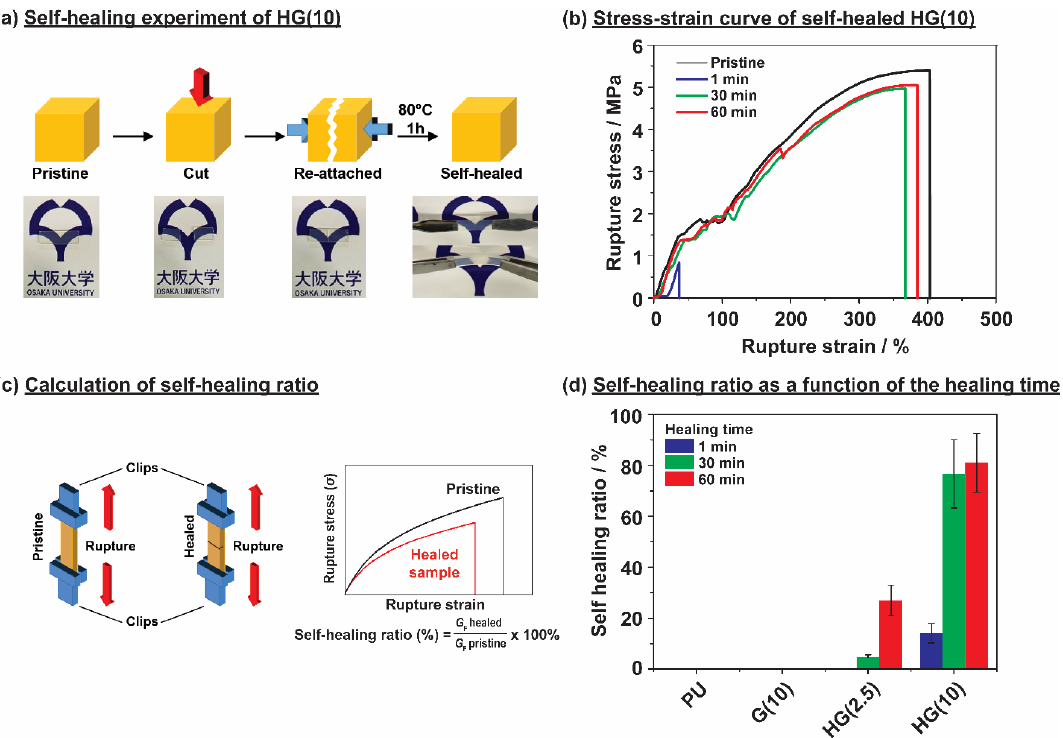
Figure 5. ( a ) Photographs of the self-healing experiment for HG(10). ( b ) Stress-strain curve of self-healed HG(10) at 80 ◦ C after 1 min, 30 min, and 60 min. ( c ) Calculation of the self-healing ratio. ( d ) Self-healing ratios of all the TPUs as a function of time. Calculated from the fracture energy. The prepared TPUs are host-guest TPU (HG( x )), linear TPU (PU), and guest TPU (G( x )). The proportions of of host and guest units in TPU are indicated by “ x ” (HG( x ) and G( x )), which represents the mol% of the PMeAm β CD and AdAm